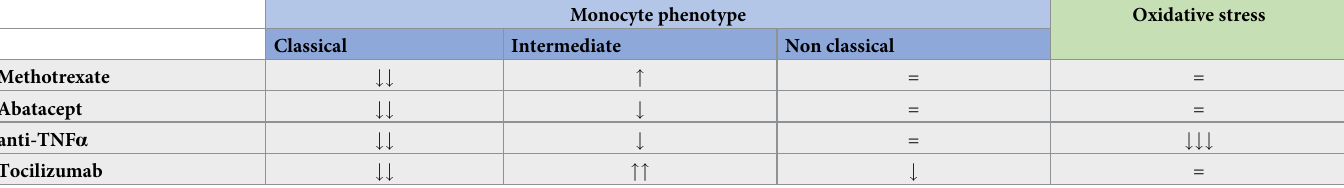
Table 2. Summary of the effects exerted by methotrexate and bDMARDs on monocyte phenotype and superoxide anion